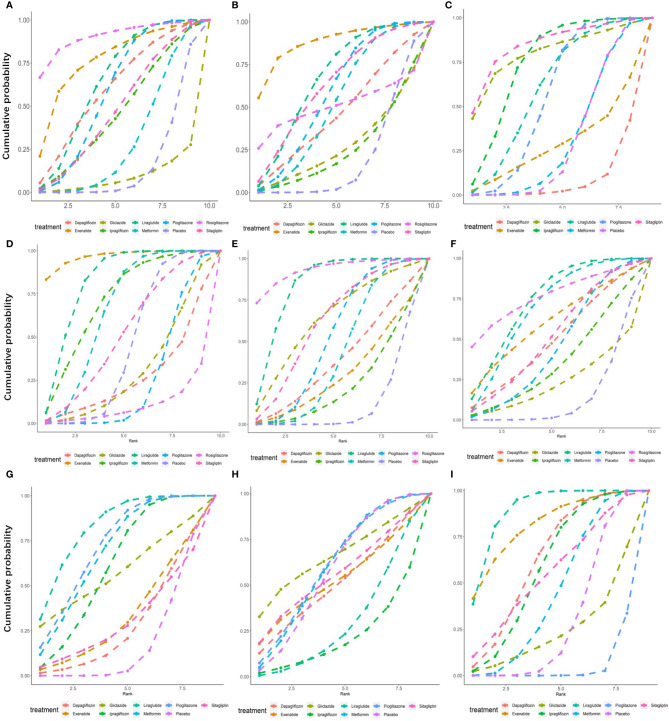
Surface under the cumulative sorting curve (SUCRA) of different hypoglycemic agents for different outcome indicators. (A) Cumulative probability of different hypoglycemic agents on ALT. (B) Cumulative probability of different hypoglycemic agents on AST. (C) Cumulative probability of different hypoglycemic agents on Triglyceride. (D) Cumulative probability of different hypoglycemic agents on BMI. (E) Cumulative probability of different hypoglycemic agents on FPG. (F) Cumulative probability of different hypoglycemic agents on HbA1c. (G) Cumulative probability of different hypoglycemic agents on HDL. (H) Cumulative probability of different hypoglycemic agents on LDL. (I) Cumulative probability of different hypoglycemic agents on Weight.